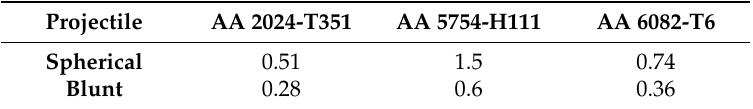
Table 4. Critical plastic deformations for each combination of projectile shape and material tested Projectile